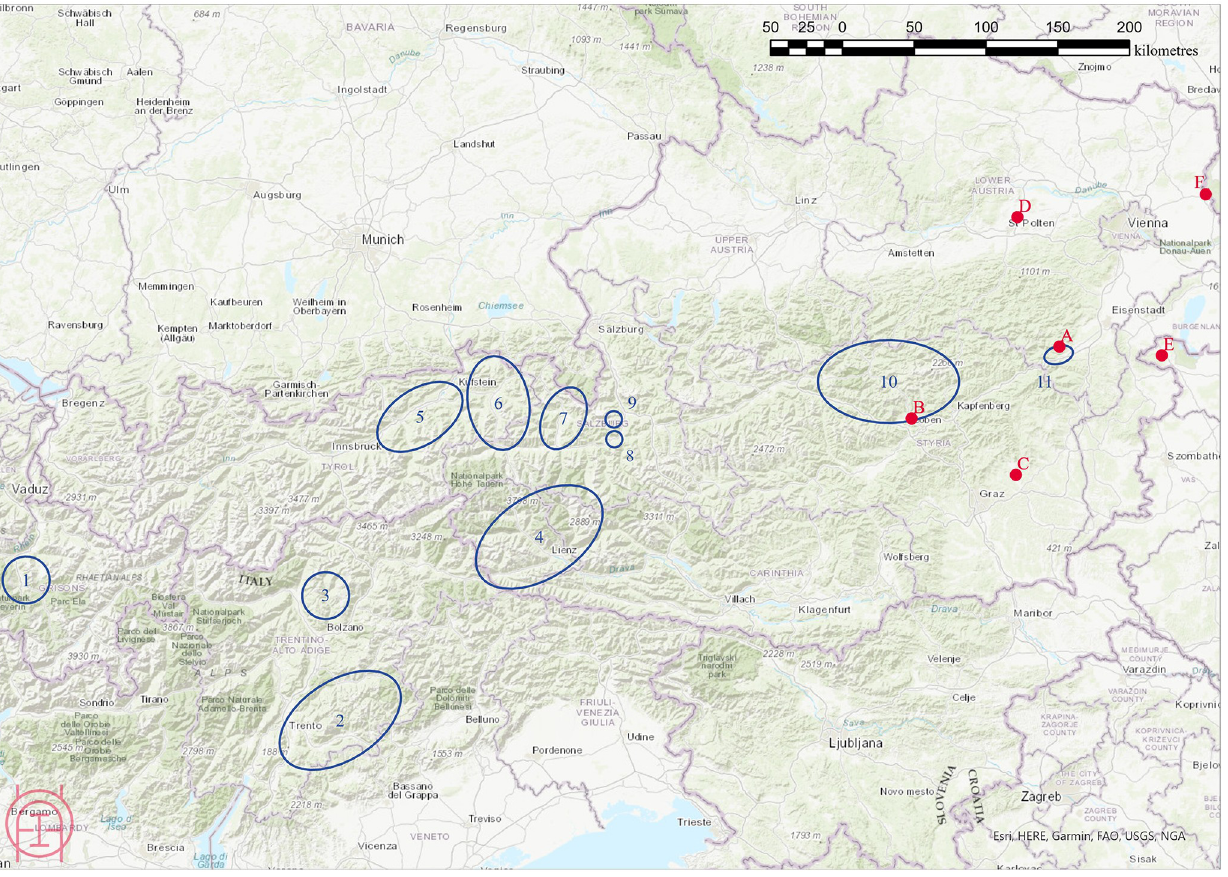
Fig 2. Map of regions and sites mentioned in the text. Blue circles: copper mining areas in the eastern Alps during the Bronze Age [2]: 1 ... Grisons, 2 ... Trentino, 3 ... South Tyrol, 4 ... East Tyrol, 5 ... Schwaz-Brixlegg, 6 ... Kitzbu¨hel-Kelchalm-Jochberg, 7 ... Saalfelden Basin, 8 ... St.